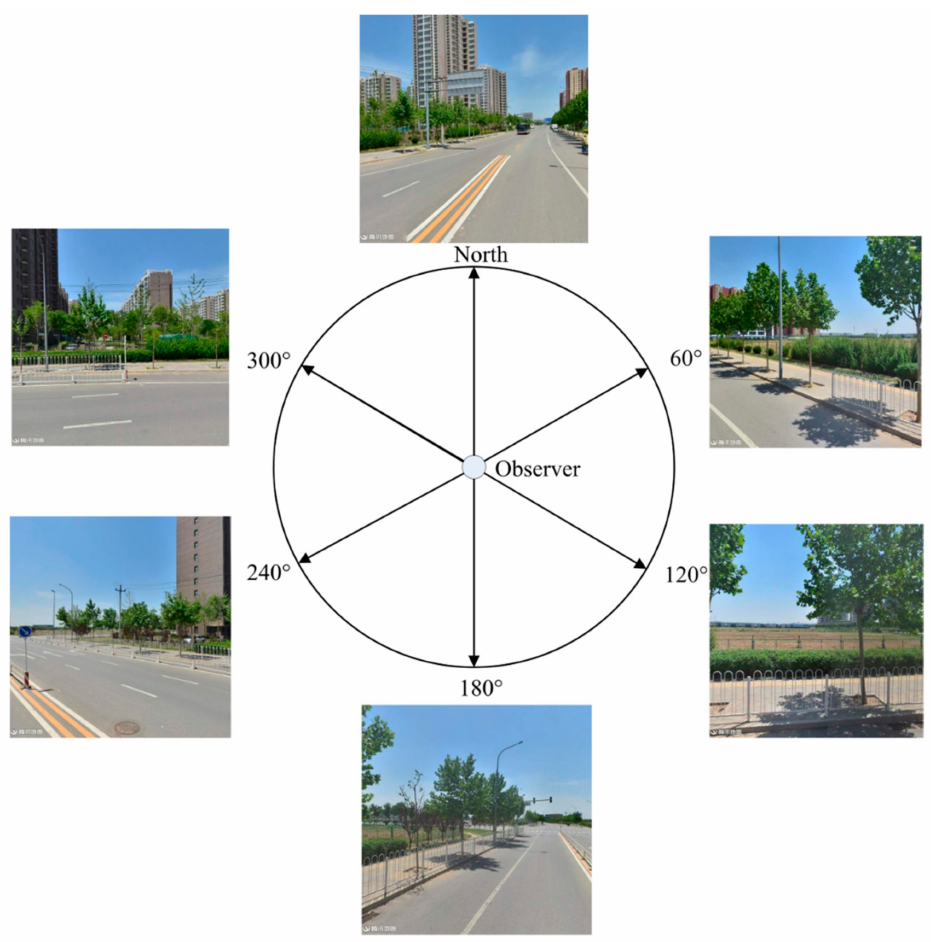
Figure 3. The configuration of Tencent street view (TSV)